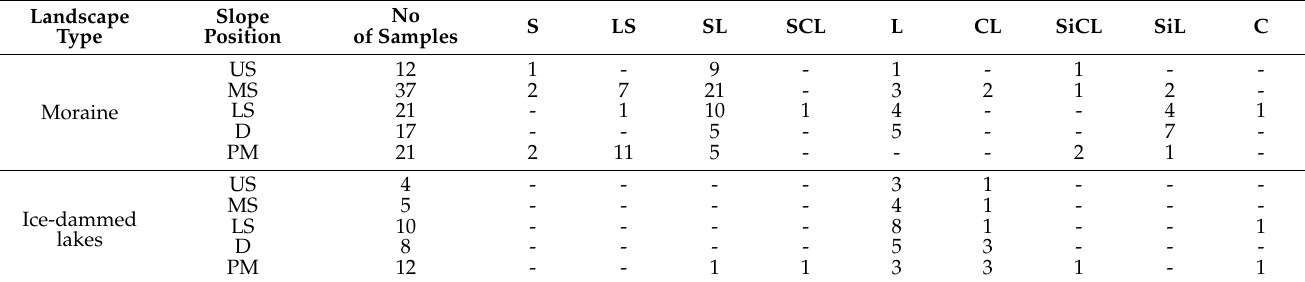
Table 2. Number of soil samples assigned to soil texture classes according to USDA (S–sand,